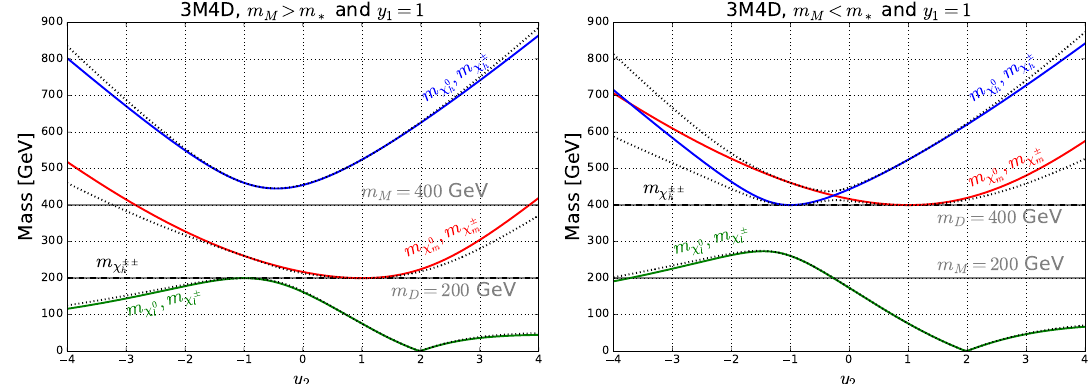
Figure 2. Mass spectra on the 3 M 4 D system for y 1 = 1 as a function of y 2 . The eigenmass of the neutral states are depicted with the same color coding as in (cid:12)gure 1; singly charged eigenmass are shown as black dotted lines; the doubly charged states have constant mass m D . These spectra are meant to illustrate the fact that the neutral and charged states combine in 2 Majorana 3 M and one 5 M of SU(2) at the custodial points y 2 = y 1 1 and, also, that they are nearly degenerate (cid:6) (cid:17) (cid:6) away from these